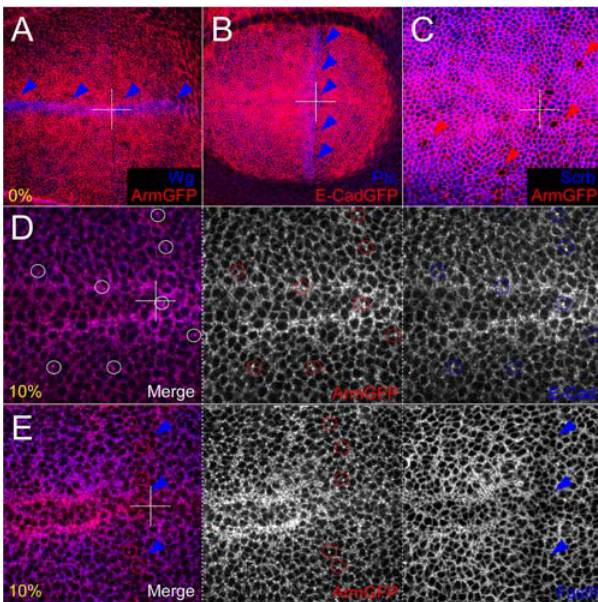
Figure 5. Distribution of Armadillo-GFP relative to basolateral markers. Armadillo-GFP (ArmGFP) and E-CadherinGFP (E-CadGFP) are expressed under endogenous Armadillo ubiquitous promoters, respec- tively. (A–C) Distribution of ArmGFP (A) and E-CadGFP (B) at AJs (red channels) are coincident; Wingless (Wg) and Patched (Ptc) outline the D/V and A/P boundaries, respectively, which are characterised by aligned cells (arrowheads, blue channel). (C) Mitotic cells express ArmGFP at the AJs, but lack septate junction markers immediately basally (red arrows, Scribble Scrb shown). (D) E-Cadherin (E-Cad, blue) and ArmGFP colocalise at membranes and in puncta (red, blue and white oultines). (E) Fasciclin III (FasIII, blue) crisply and exclusively marks basolateral membranes, with which ArmGFP puncta are closely associated (compare red and blue channels). The downregulation of FasIII at the A/P boundary (blue arrowheads) clearly outlines the ArmGFP puncta there (outlined in red).